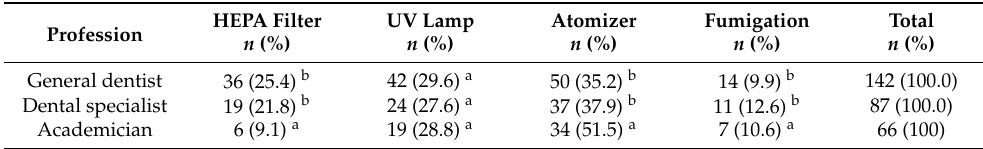
Table 2. Differences between various preventive modalities added to the clinics with different groups of dentists.